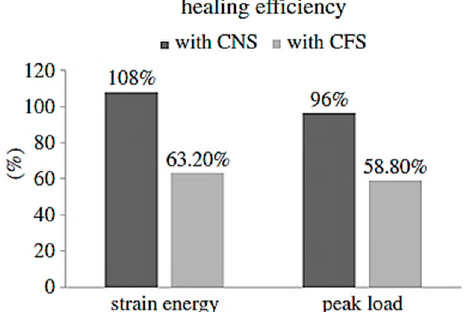
Figure 5. Healing efficiency of nanocomposites with CNS and CFS nanomaterial. CNS = carbon nanotube nanosheet; CFS = copper foam sheet. Reprinted with permission from [101]. 2016, Royal